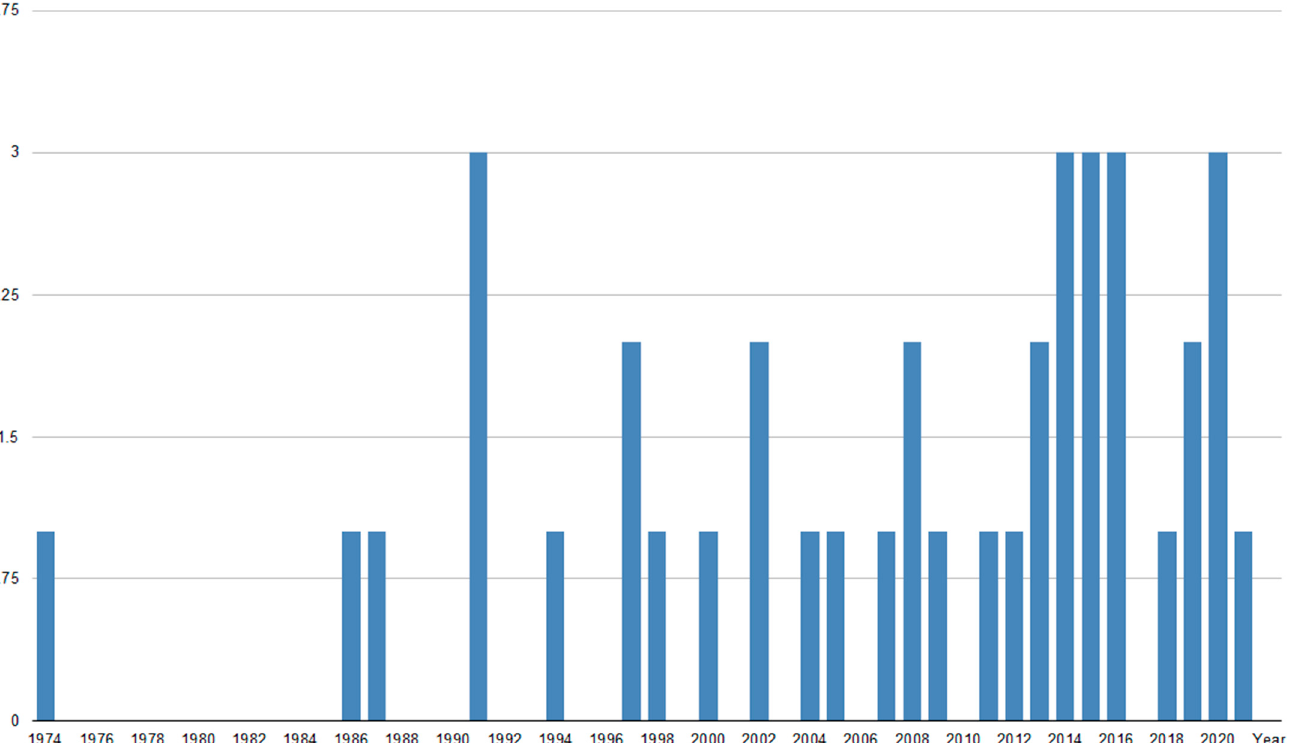
Figure 1. The number of publications per year on radiotherapy for leptomeningeal carcinomatosis in breast cancer (Pubmed.gov database).